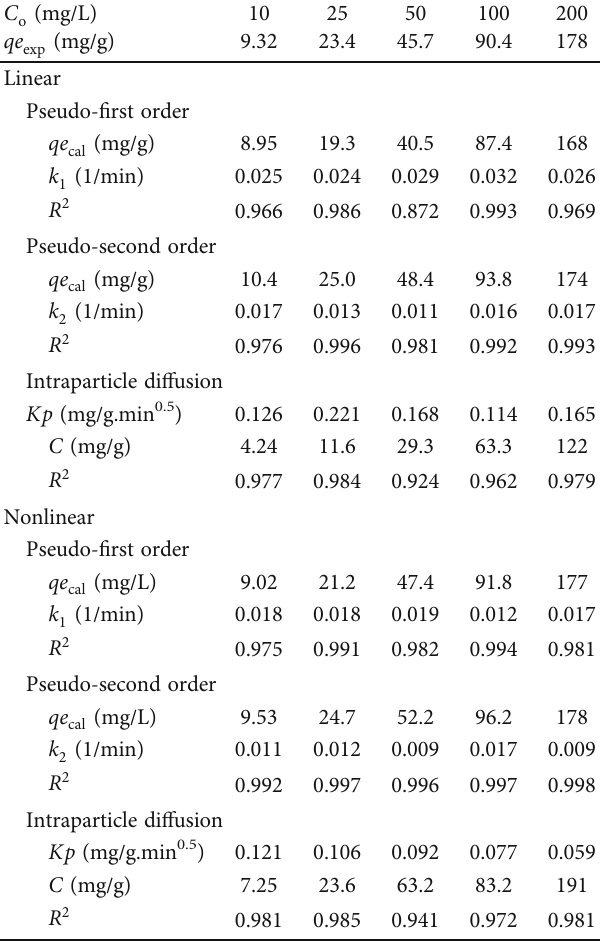
Table 6: Kinetic model parameters of Pb (II) adsorption at 35 ° C. Table 5: Error analysis of isotherm adsorption parameters.